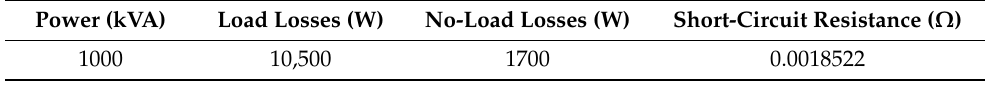
Table 4. Nominal features of 1000 kVA Ormazabal distribution